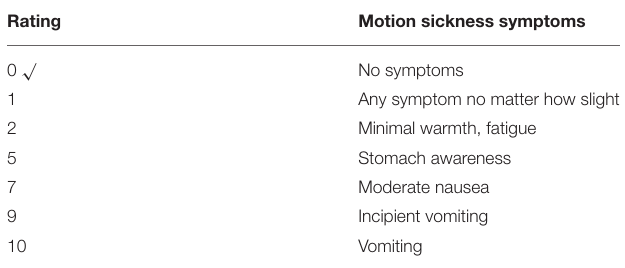
TABLE 3 | Motion sickness symptom scale.